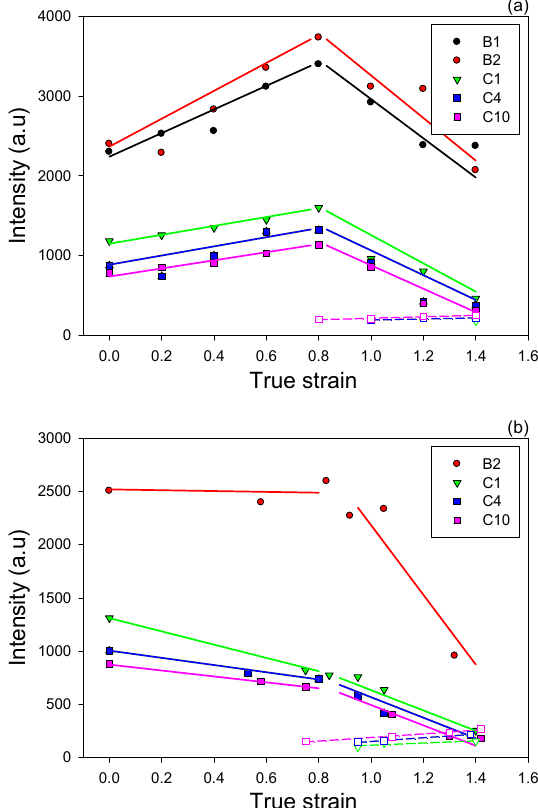
Figure 19. Dependencies of the maximum intensity in four-point pattern (filled symbols and solid lines) and in the two-point pattern emerging along FD in copolymer samples (open symbols and dashed lines) on true strain determined from SAXS images: ( a ) compressed samples, CD-view images; and ( b ) tensile samples, TD-view images. Straight line segments were drawn to guide eye only, and they do not represent any real dependence.